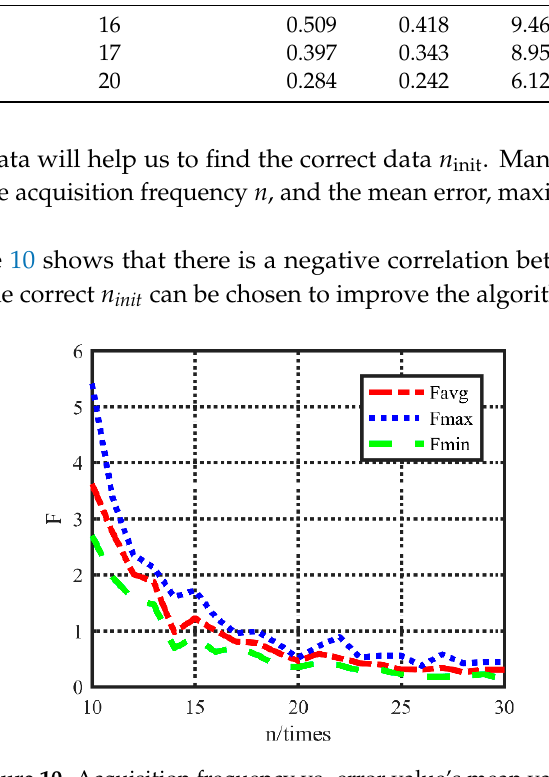
Table 1. Di ff erent FIT max , acquisition frequency and error.